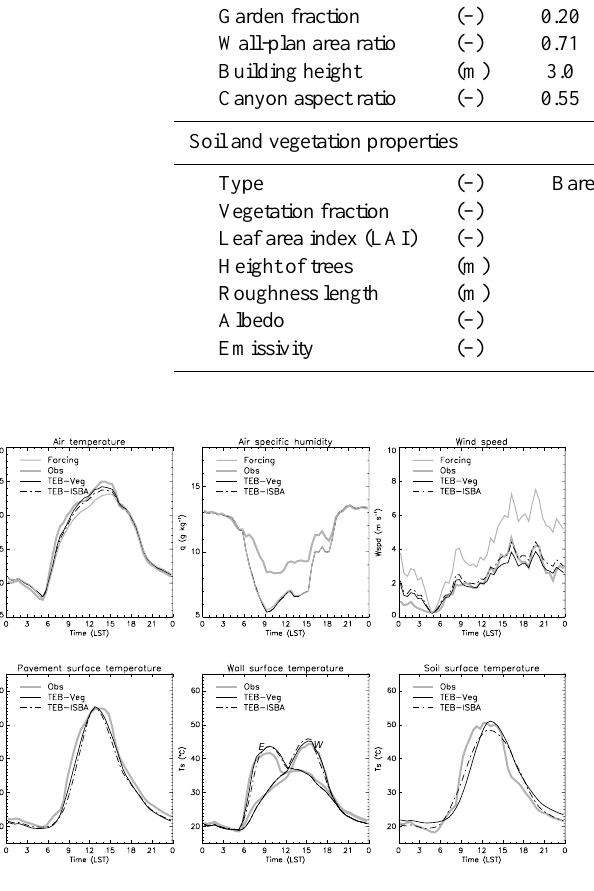
Fig. 5. Comparison of the TEB-Veg and TEB-ISBA results (black thin lines) with observations collected within the courtyards (gray thick line) for the Exposed-Bare experiment. For air temperature, specific humidity and wind speed, the gray thin line indicates the forcing data at 10ma.g.l. For walls, surface temperature measure- ments are plotted by facet for both eastern (E) and western (W)